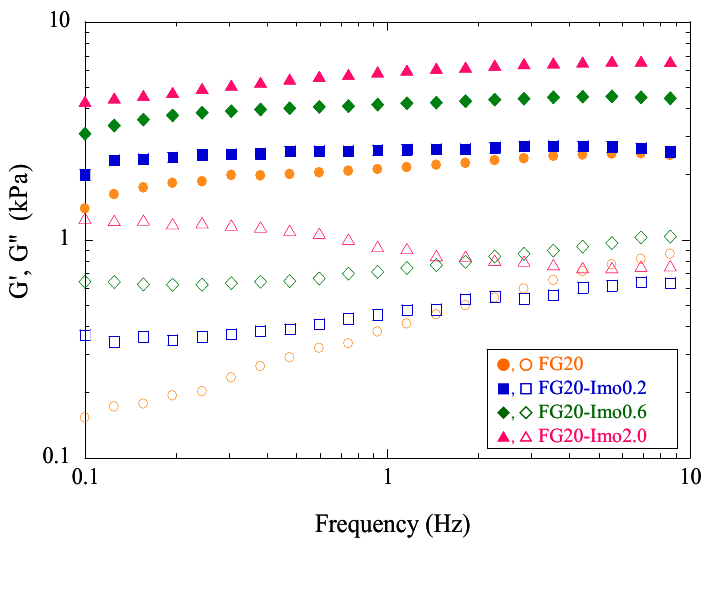
Figure 7. Frequency dependency of storage modulus, G' (filled symbols), and loss modulus, G'' (open symbols), for FG20 composite hydrogels at different imogolite content varied from 0% to